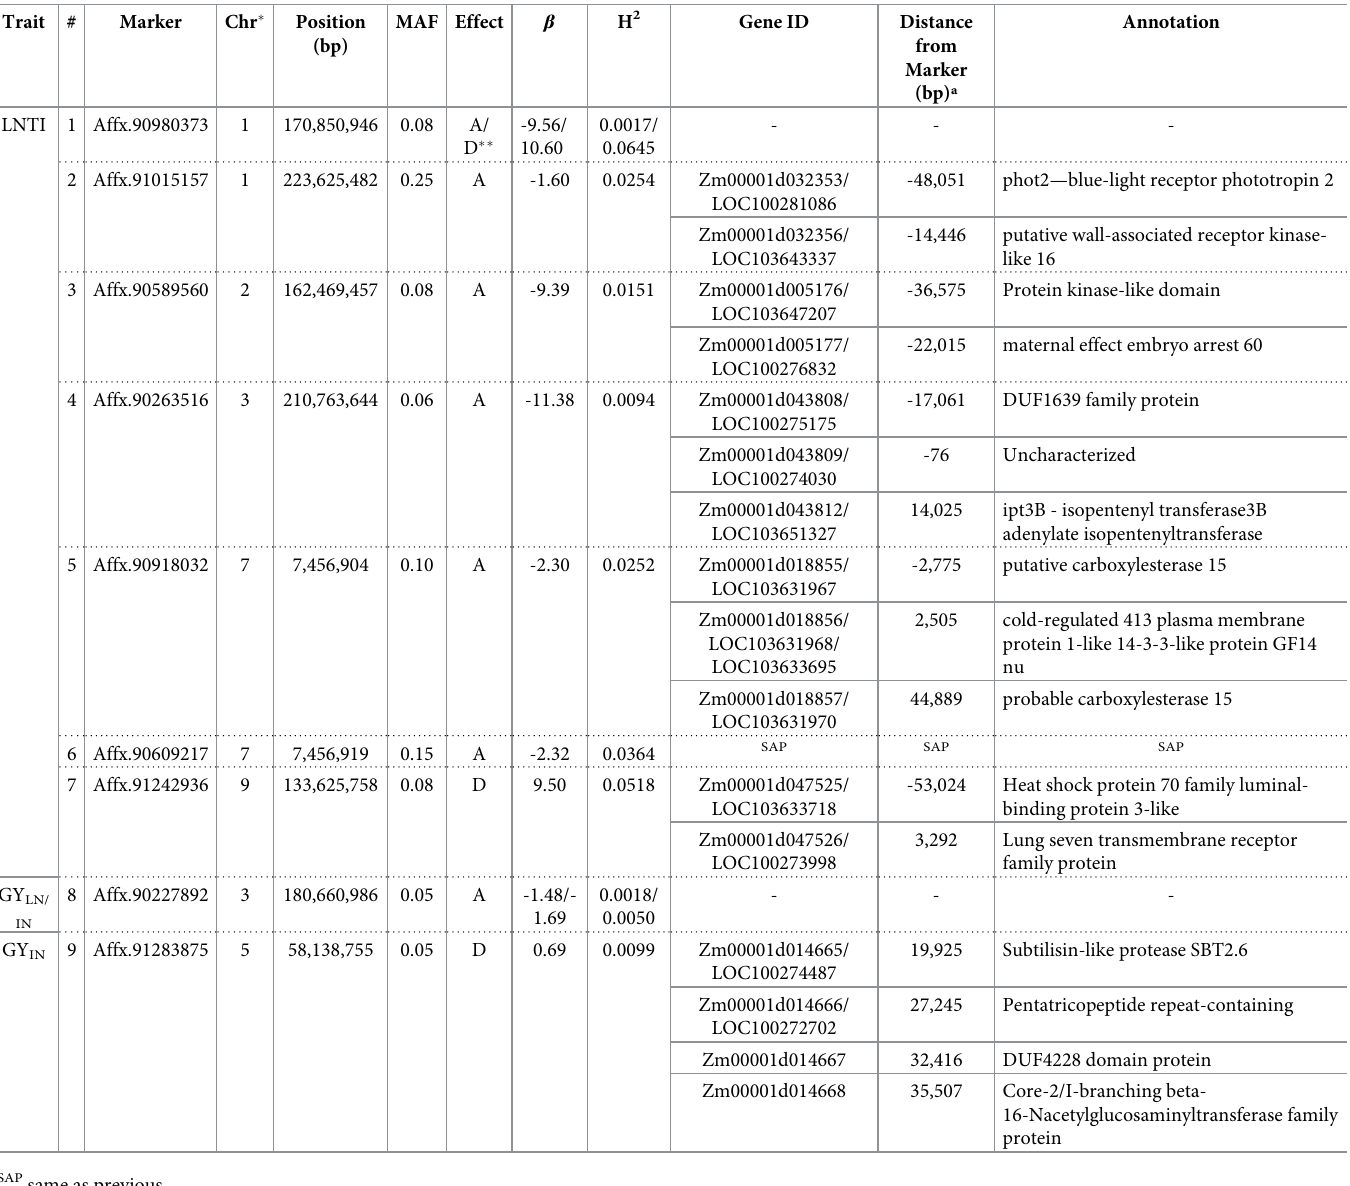
Table 1. List of markers significantly associated with LNTI, GYLN, and GYIN by GWAS of 904 hybrids with 34,571 markers with chromosome (Chr), position (in base pairs), minor allele frequency (MAF), type of effect tested, value of the marker regression coefficient ( β ), marker effect heritability (H 2 ), gene identification (Gene ID), distance between gene and marker, and